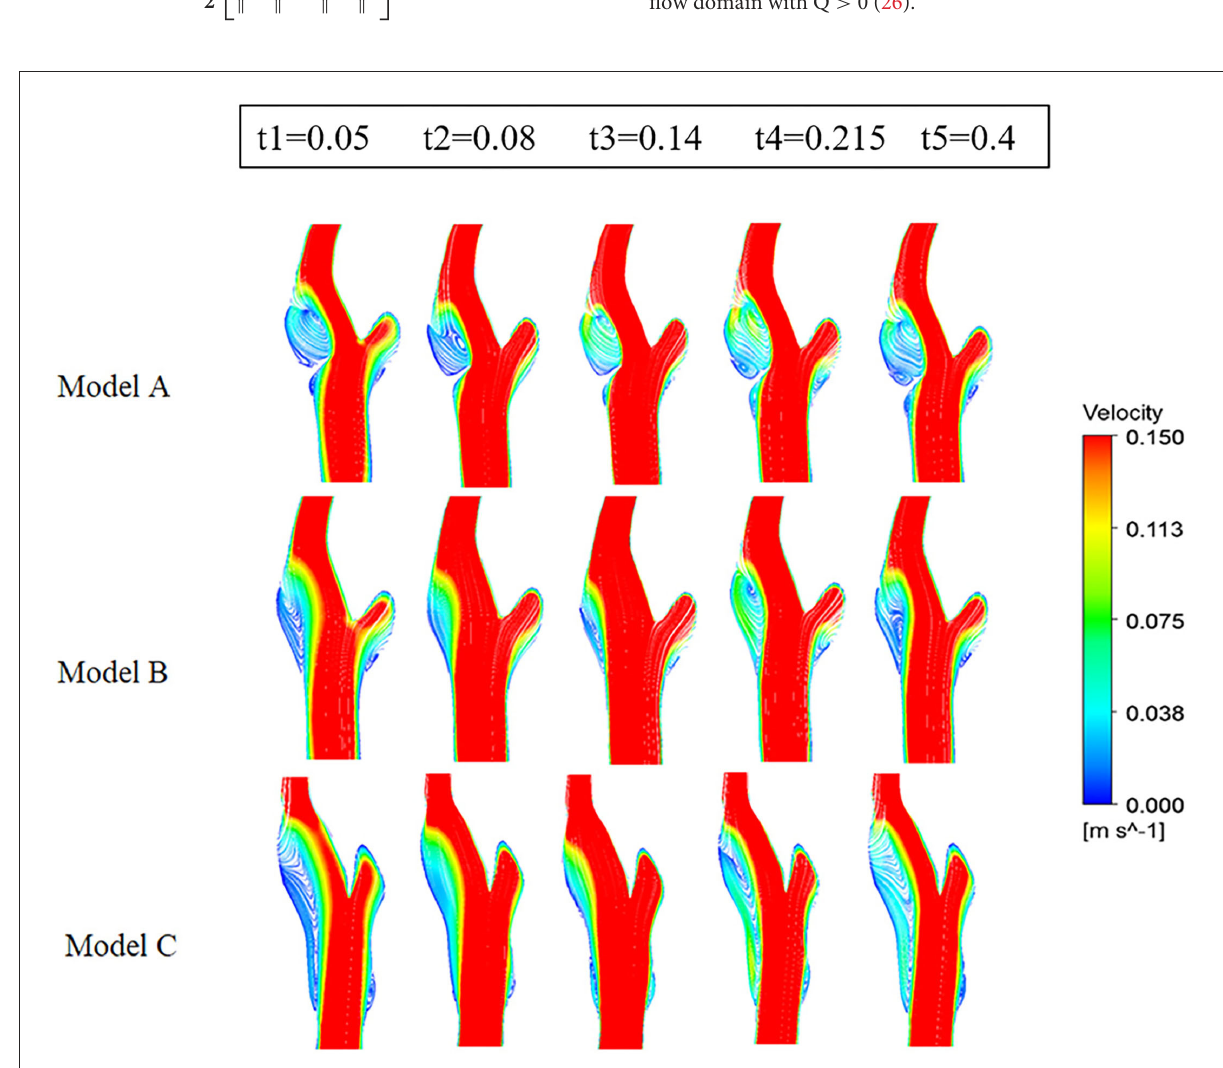
FIGURE5 Velocity streamlines on cross sections at five